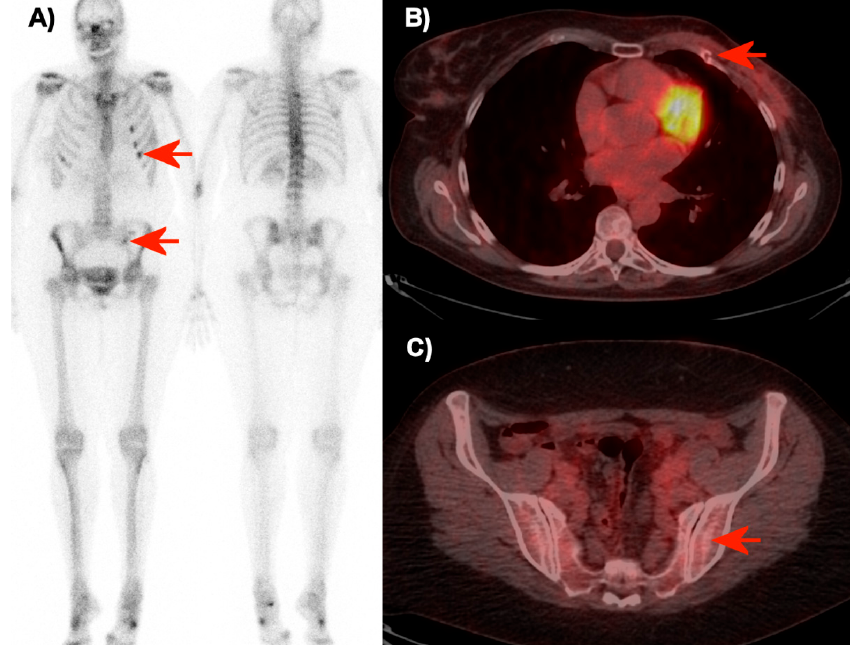
Figure 1. Bone scintigraphy ( A ) and transaxial FDG-PET/CT images over the thorax ( B ) and pelvis ( C ) of a 50-year-old woman without metastases (seven months of follow-up). The raters